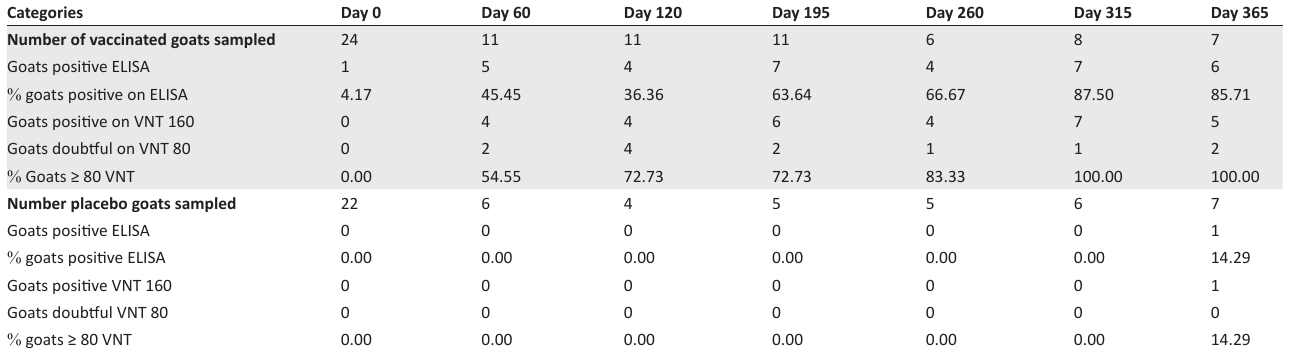
TABLE 4: Enzyme-linked immunosorbent assay and viral neutralisation test results in goats.